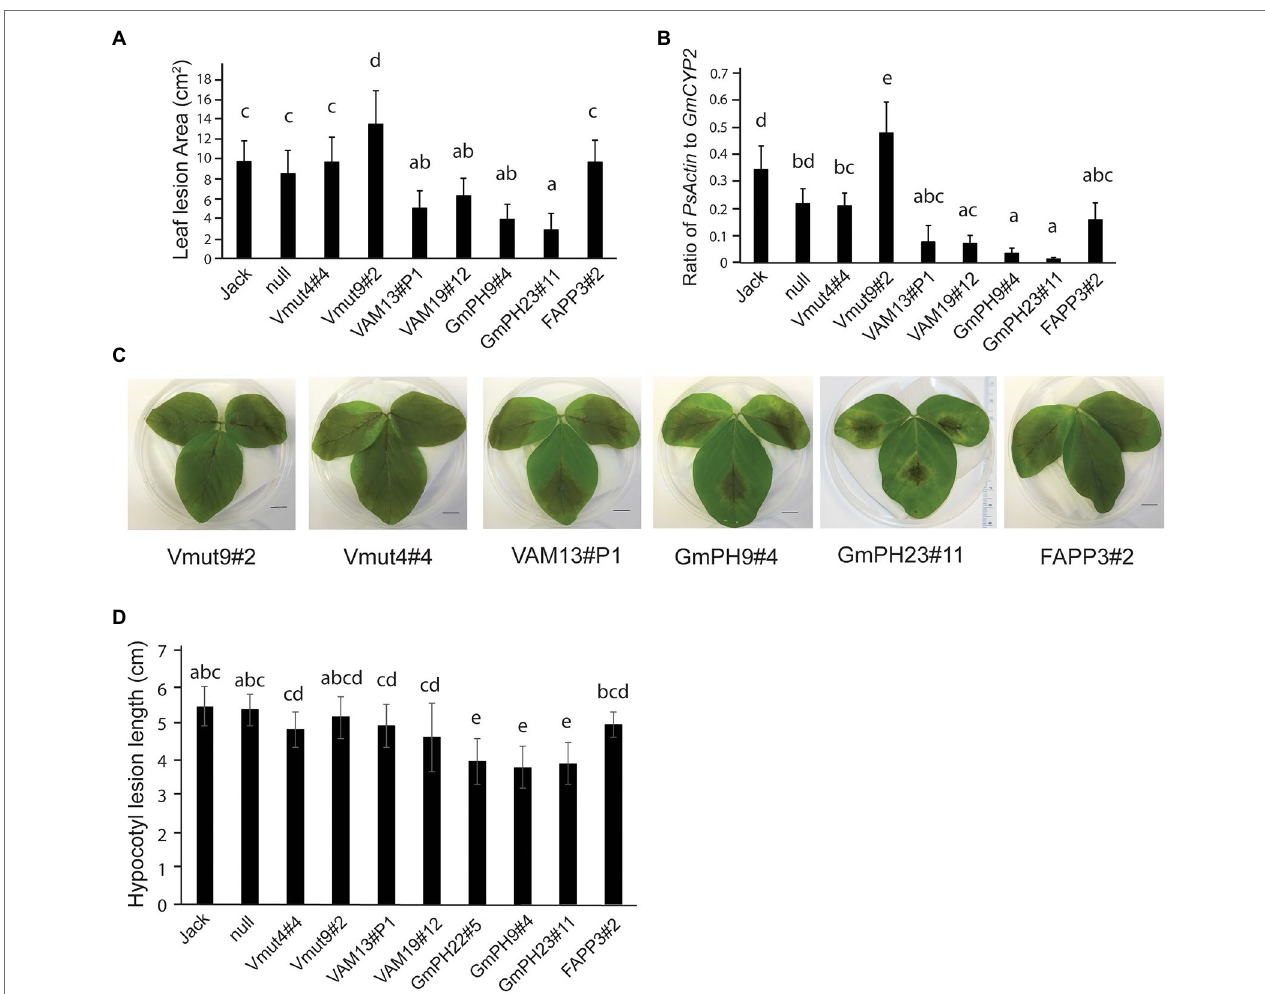
FIGURE 2 | Inoculation of transgenic lines with Phytophthora sojae . (A) Lesion area measured 4 days after inoculation by zoospores of P. sojae strain P6497. Jack is the non-transformed cultivar and null is the null segregant originating from the VAM7-19 transgenic population (B) Ratio of P. sojae Actin genomic DNA to Glycine max CYP2 genomic DNA in leaves, 4 days after inoculation by P. sojae zoospores. (C) Representative photographs of 2nd trifoliate leaves, 4 days after inoculation by P. sojae zoospores. (D) Length of P. sojae lesions 3 days after inoculation of soybean hypocotyls by mycelia. In (A,B,D) , letters represent different significance groups as measured by one-way ANOVA ( p < 0.05). Letters represent different significance groups. Averages of 12 plants from each of three independent biological replicates are shown for all graphs; bars indicate